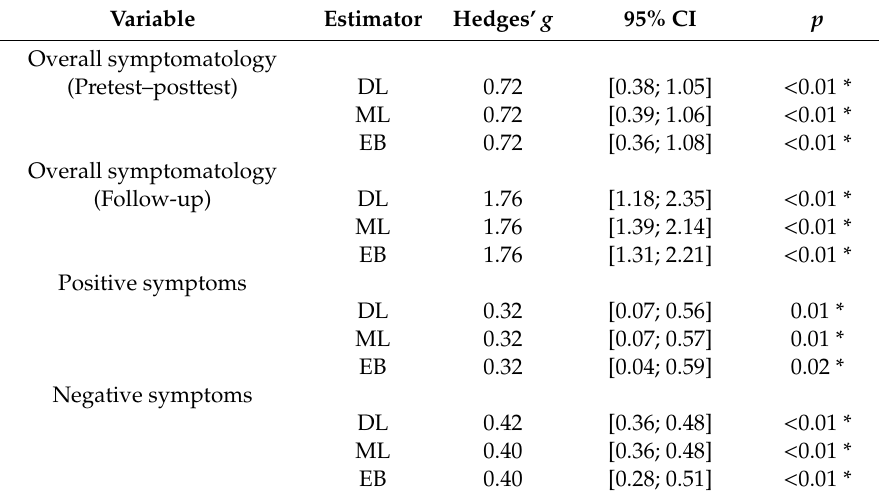
Table 2. Sensitivity